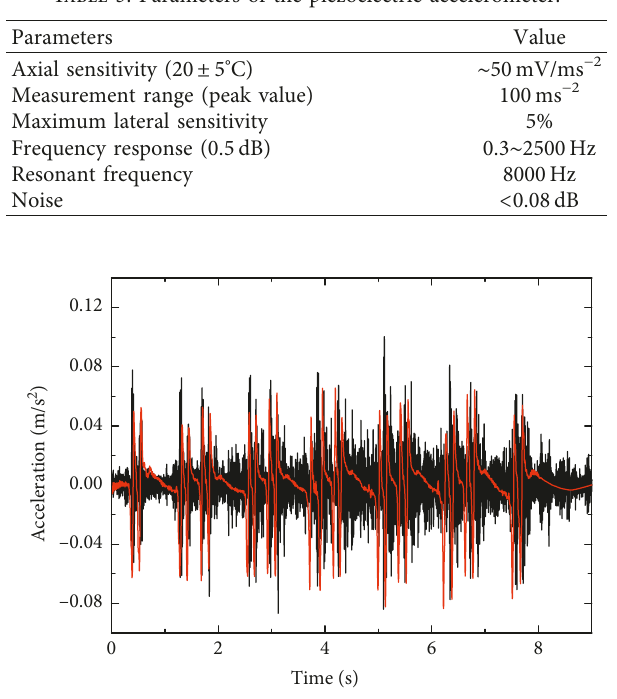
Table 3: Parameters of the piezoelectric accelerometer.